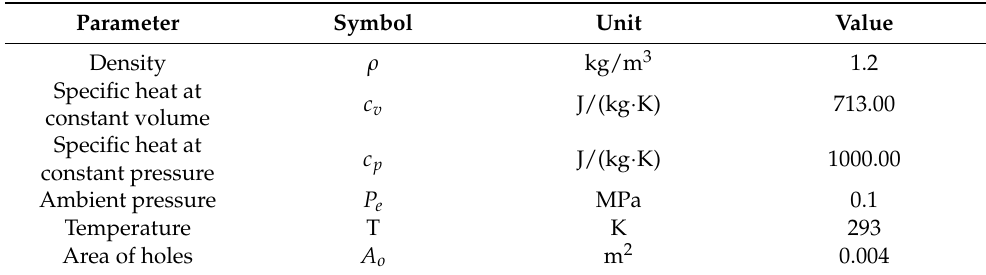
Figure 13. Numerical model of the homogeneous honeycomb material, with surfaces used as air- leakage boundaries. Table 5. Parameters of the air enclosed inside the cores, according to the assumptions of the AIR-